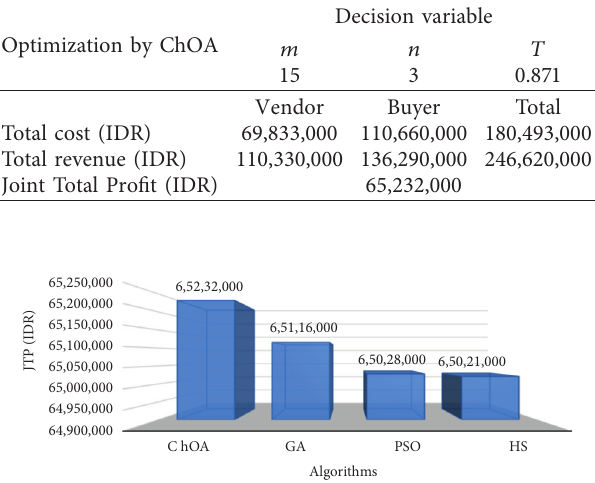
Figure 6: Comparison of algorithms.